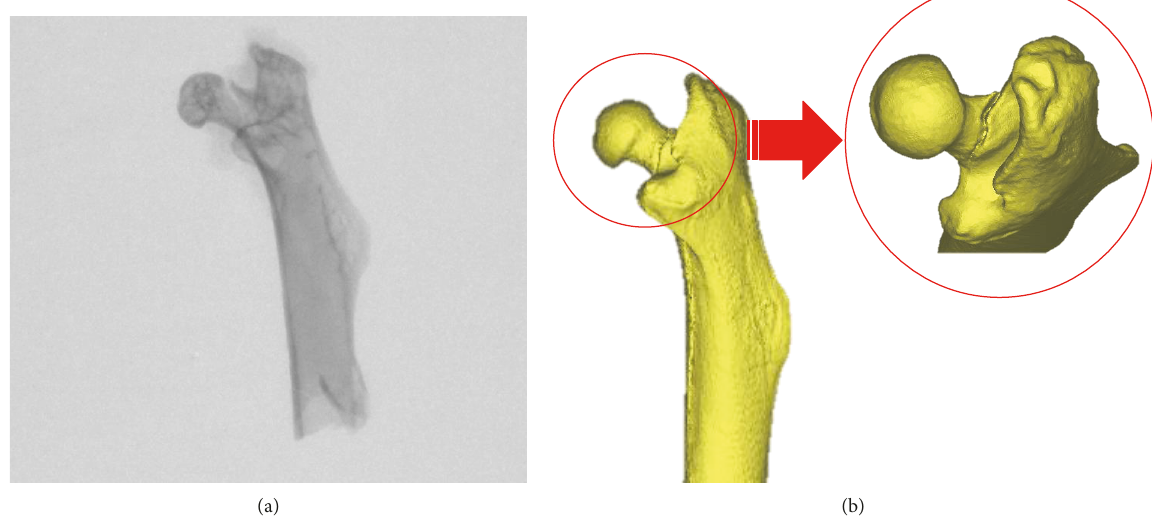
Figure 8: Example of femur neck fracture. (a) Micro-CT image. (b) 3D reconstruction image for femoral